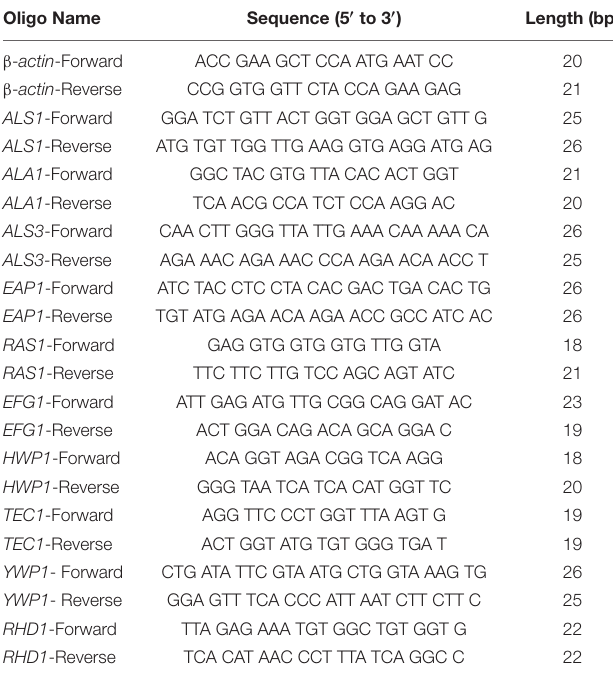
TABLE 1 | Primers for